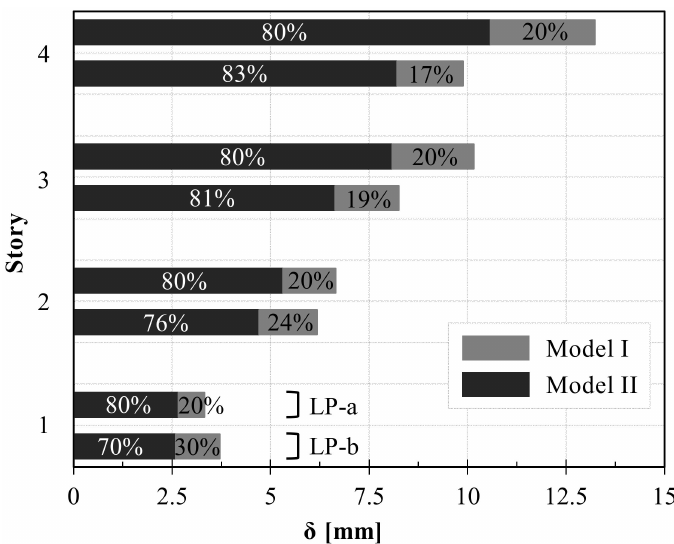
Figure 9. Building’s lateral maximum displacement under DL limit state loading for LP-a and